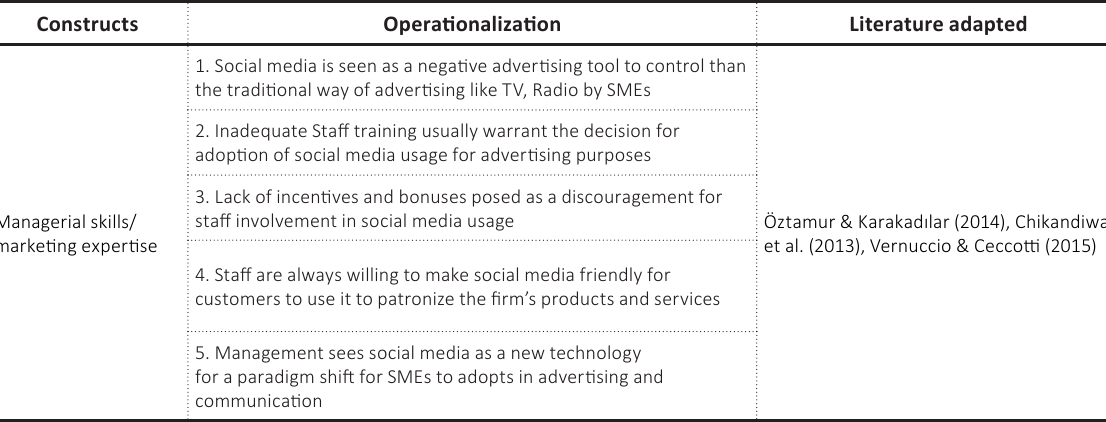
Table 2. Measurement of сonstructs